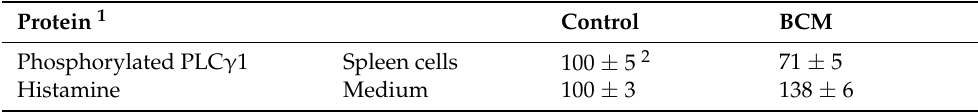
Table 1. Protein levels of phosphorylated phospholipase C (PLC) γ 1 and